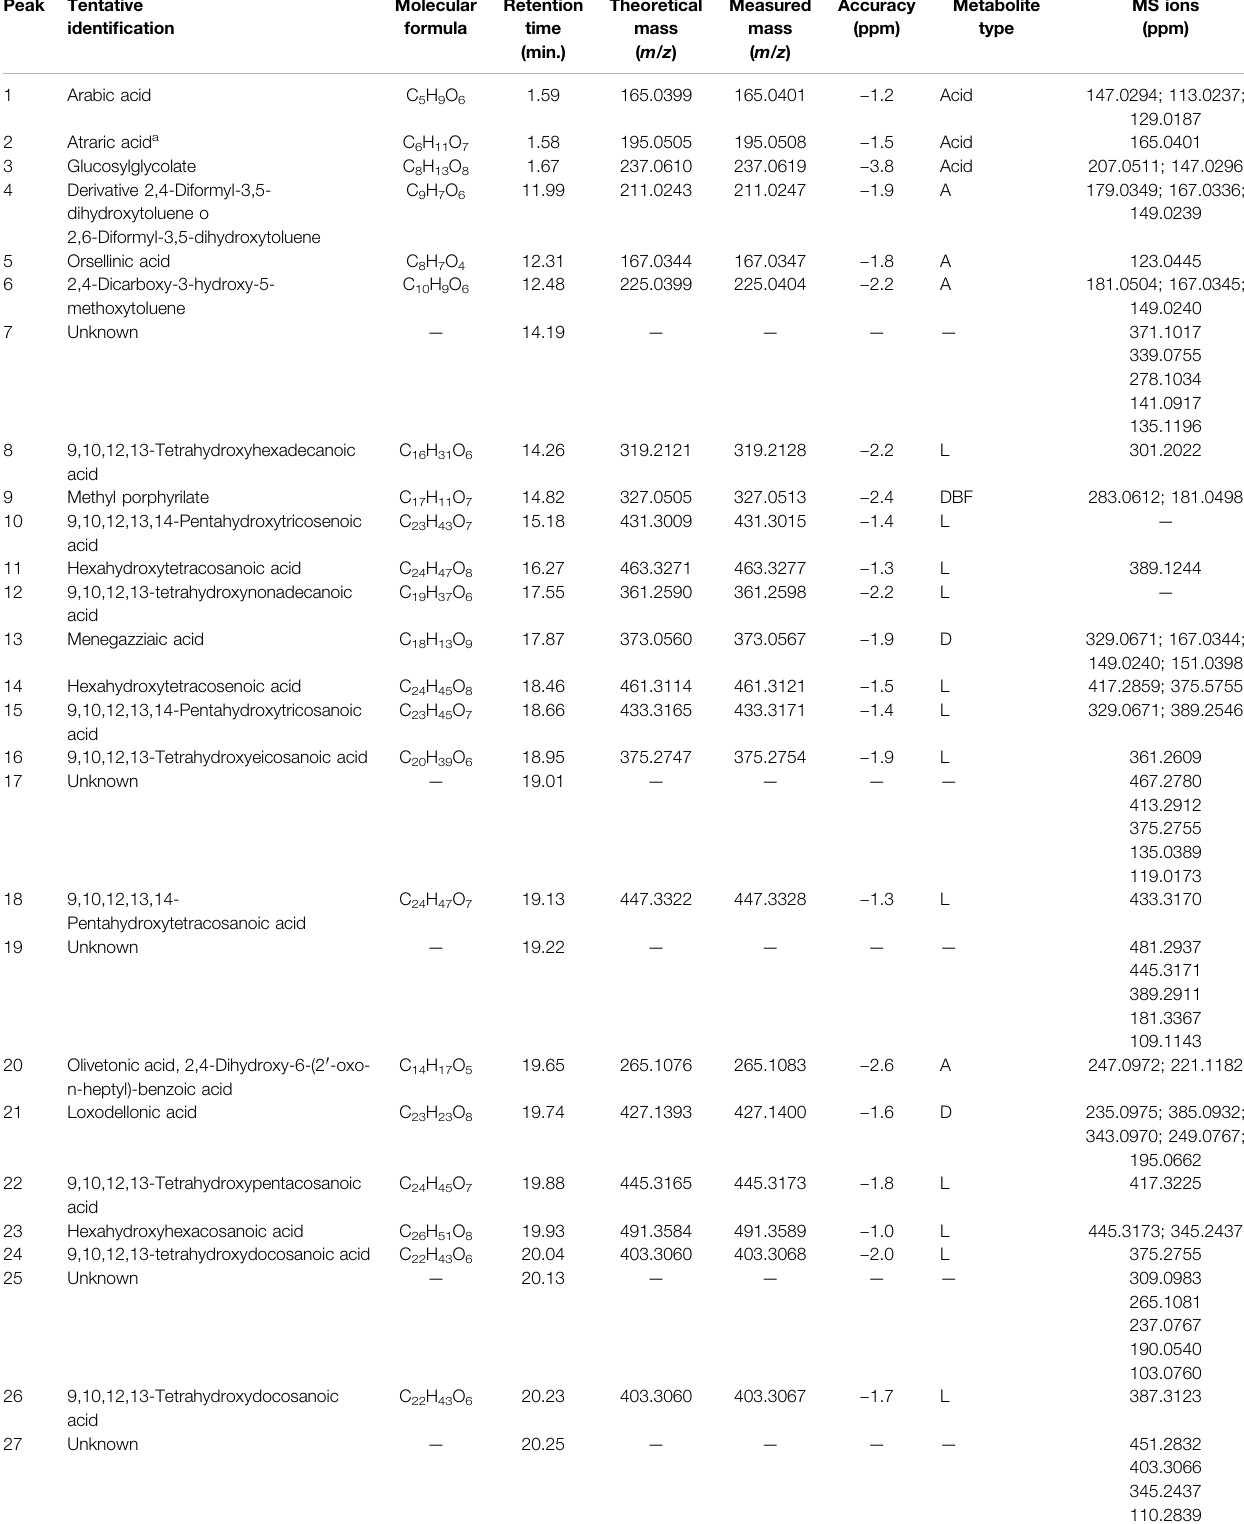
TABLE 3 | Biochemical composition of 70% methanol extract by UHPLC-DAD-MS analysis the negative ion mode. Peak Tentative identi fi